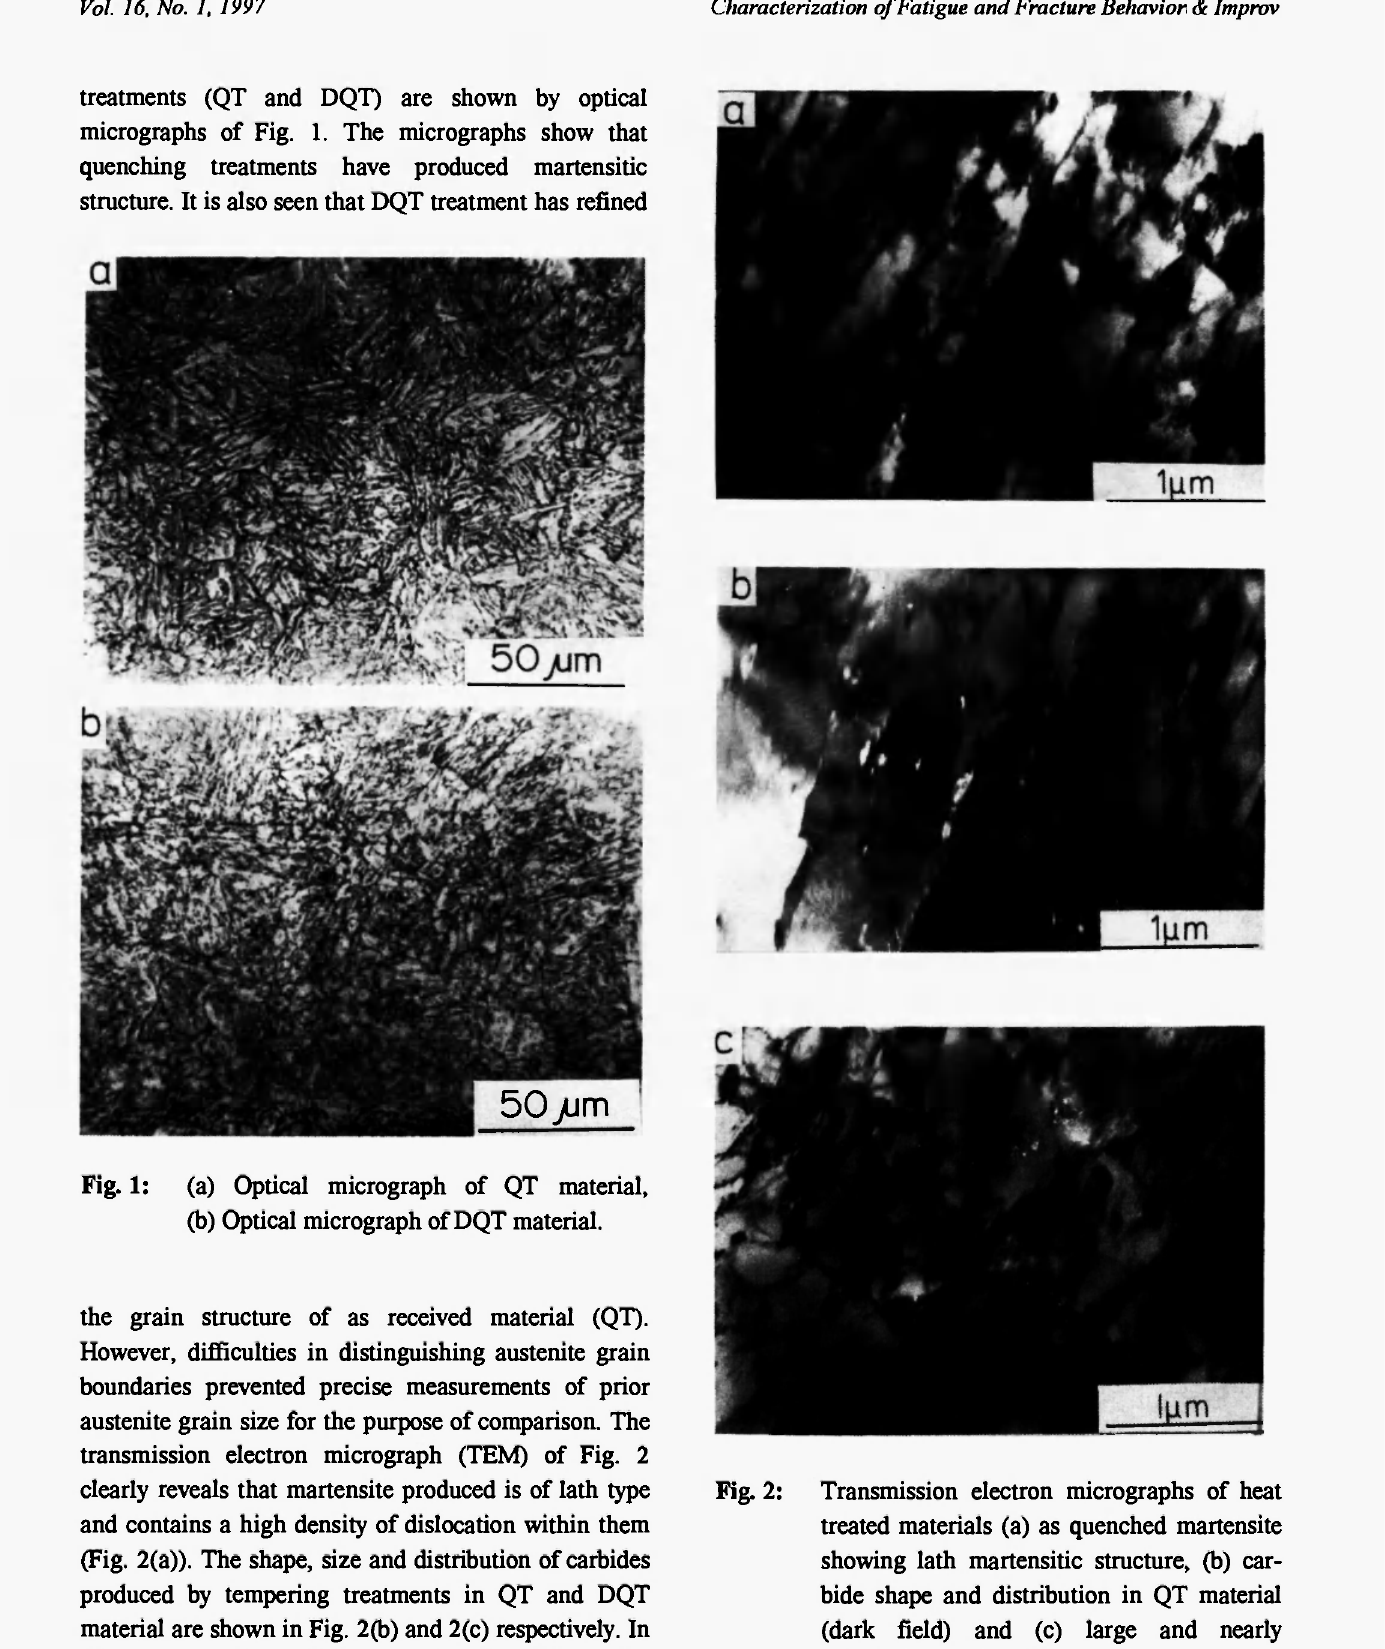
Fig. 2: Transmission electron micrographs of heat treated materials (a) as quenched martensite showing lath martensitic structure, (b) car- bide shape and distribution in QT material (dark field) and (c) large and nearly spherical shaped carbide in DQT material.